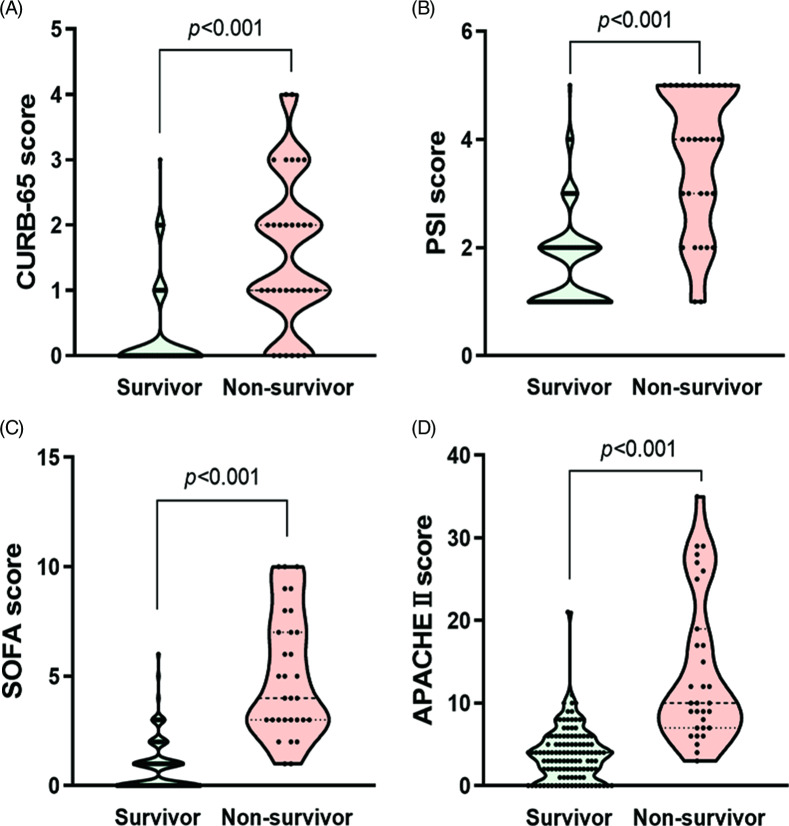
Comparison of pneumonia severity score and critical illness score between survivors and nonsurvivors. Violin diagram shows the higher CURB-65 score (A), PSI score (B), SOFA score (C), and APACHE II score (D) in the nonsurvivors. PSI, Pneumonia Severity Index; SOFA, Sequential Organ Failure Assessment; APACHE II, Acute Physiology and Chronic Health Evaluation II.